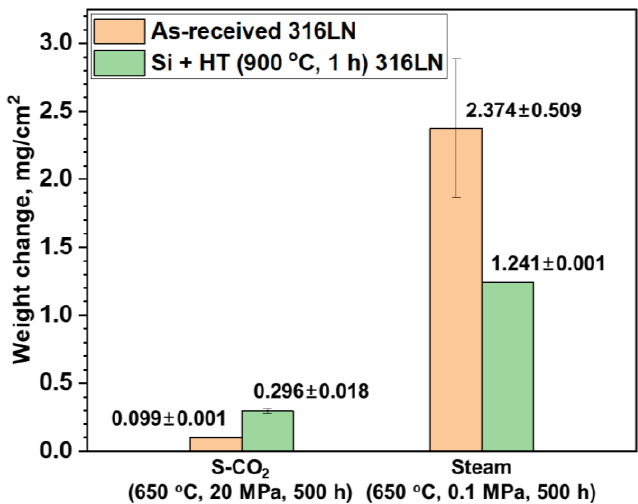
Figure 3. Weight changes of the as-received and surface-modified SS 316LN after exposure to S-CO 2 (650 °C, 20 MPa, 500 h) and steam (650 °C, 0.1 MPa, 500 h) environments.